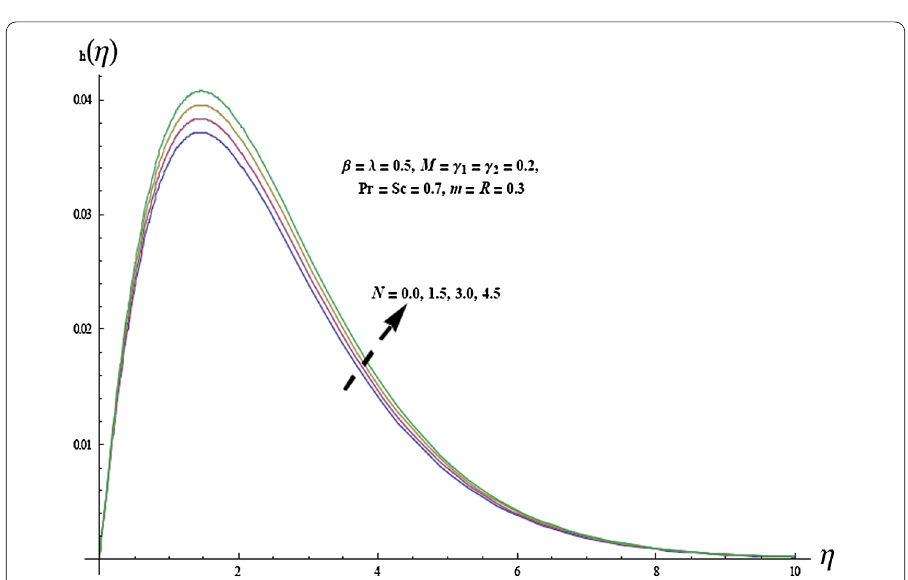
Figure 8 Variation of λ on h ( η ).